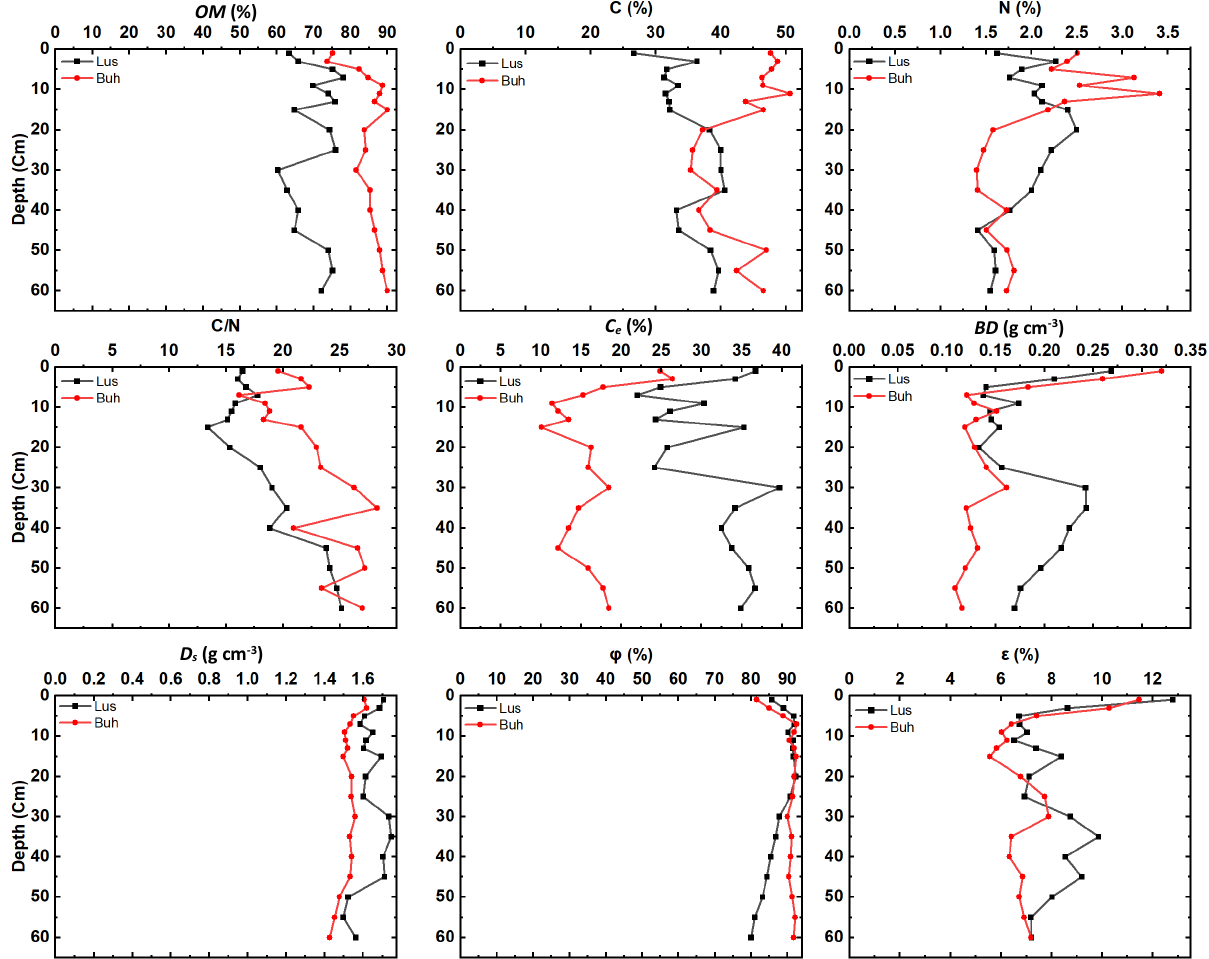
Figure 5. Physicochemical characteristics of peat cores from the first (2017) field campaign at Buhandanda (Buh) and Lushala (Lus). The profiles show, from left to right: organic matter ( OM ), carbon (C), nitrogen (N) (top row); C/N, ash content ( C ), bulk density ( BD ) (middle row); density of solids ( D e ( φ ) and air-filled porosity ( ε ) (bottom